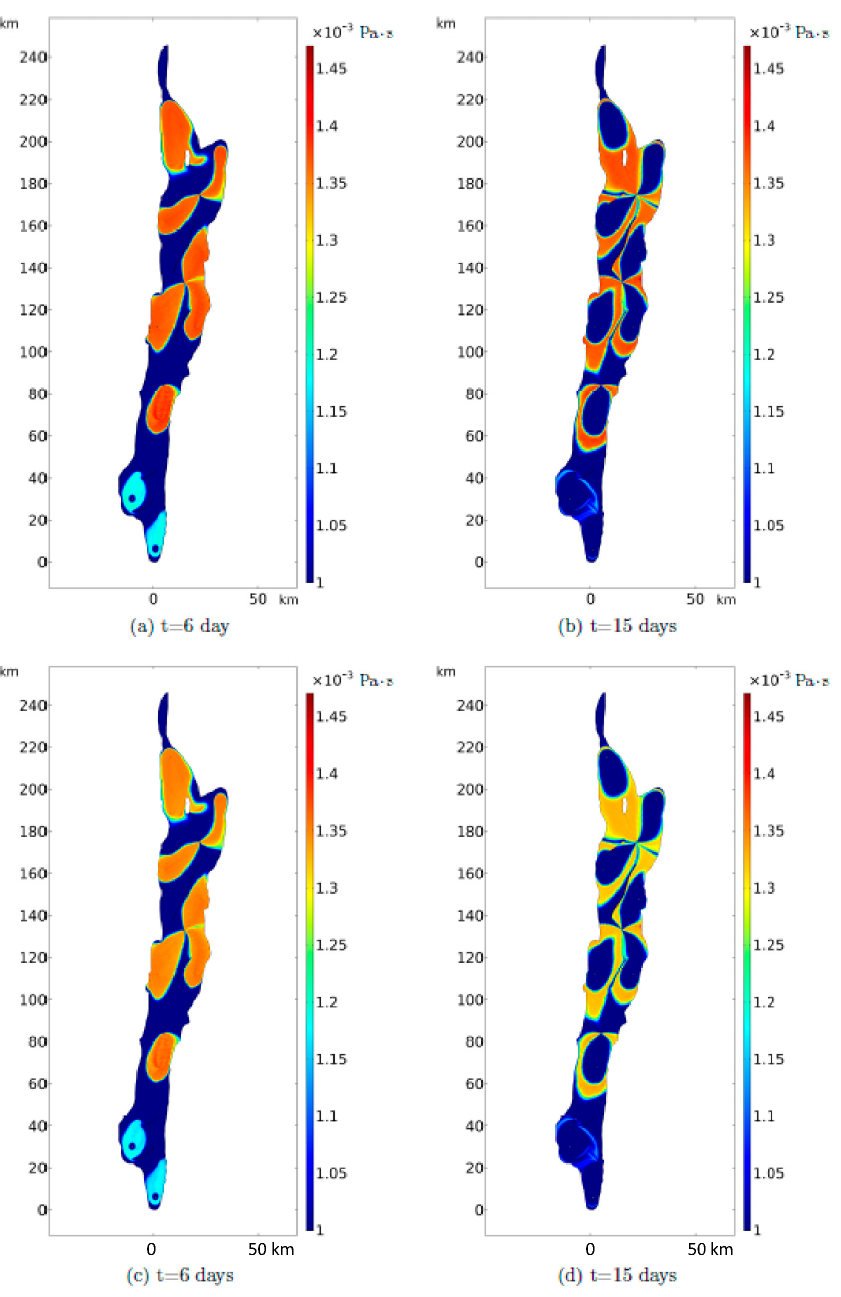
Figure 19. Viscosity of the Ghawar field for polymer flooding without degradation ( a , b ) and with degradation ( c , d